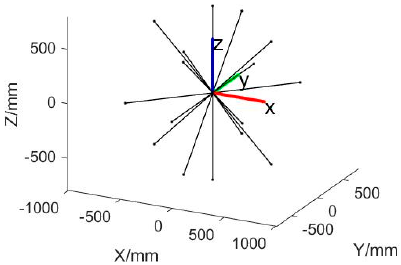
Figure 4. The six orientations of the bar in one position.